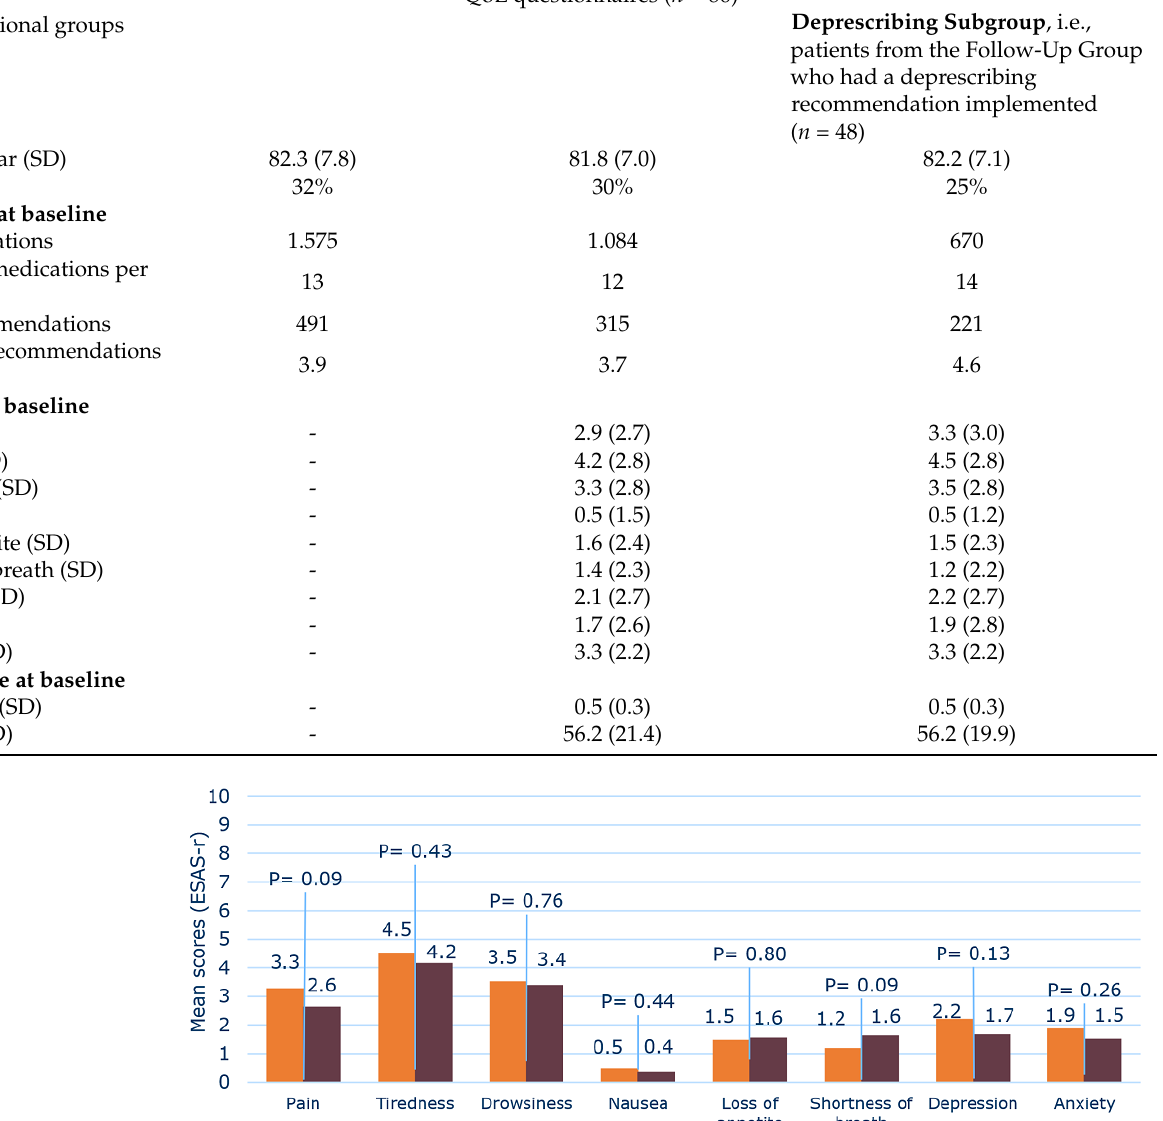
Figure 2. Mean scores of the Deprescribing Subgroup ( n = 48) for each symptom, measured using the Edmonton Symptom Assessment System (revised version) (ESAS-r) scale, before deprescribing (orange) and after deprescribing (brown). The ESAS-r scale uses a numeric scale from 0 – 10, where 0 indicates no symptoms and 10 indicates the worst intensity of a symptom. There was no significant difference for any symptoms.